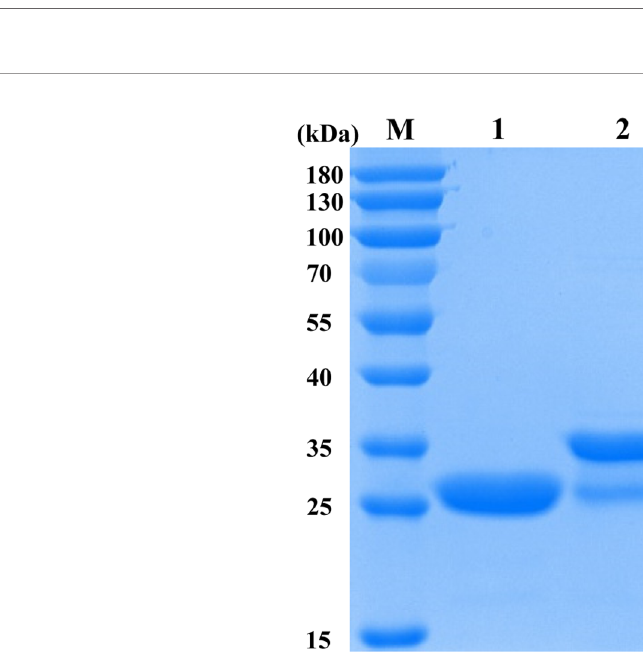
FIGURE 3 | The amino acid sequence and tertiary structure of grass carp C3a.1. (A) Native C3a.1 is generated in the complement-activated grass carp serum. The. complement-activated grass carp serum was separated by gel fi ltration chromatography, and the fractions with molecular masses of 8-9 kDa were collected to detect C3a.1 by Western blotting. (B) Amino acid sequence alignment of grass carp (gc) C3a.1 with human (hu) C3a. The sequence alignment was conducted using the Clustal program. The functional region of huC3a as well as the C-terminal peptide of gcC3a.1 synthesized for functional study are underlined. (C) Tertiary structure of grass carp C3a.1. The tertiary structure of grass carp C3a.1 was modeled using the I-TASSER On-line Server based on the structure of human C3a. The. symbols *, : , and . indicate the identities of the corresponding amino acid residues, from high to low.